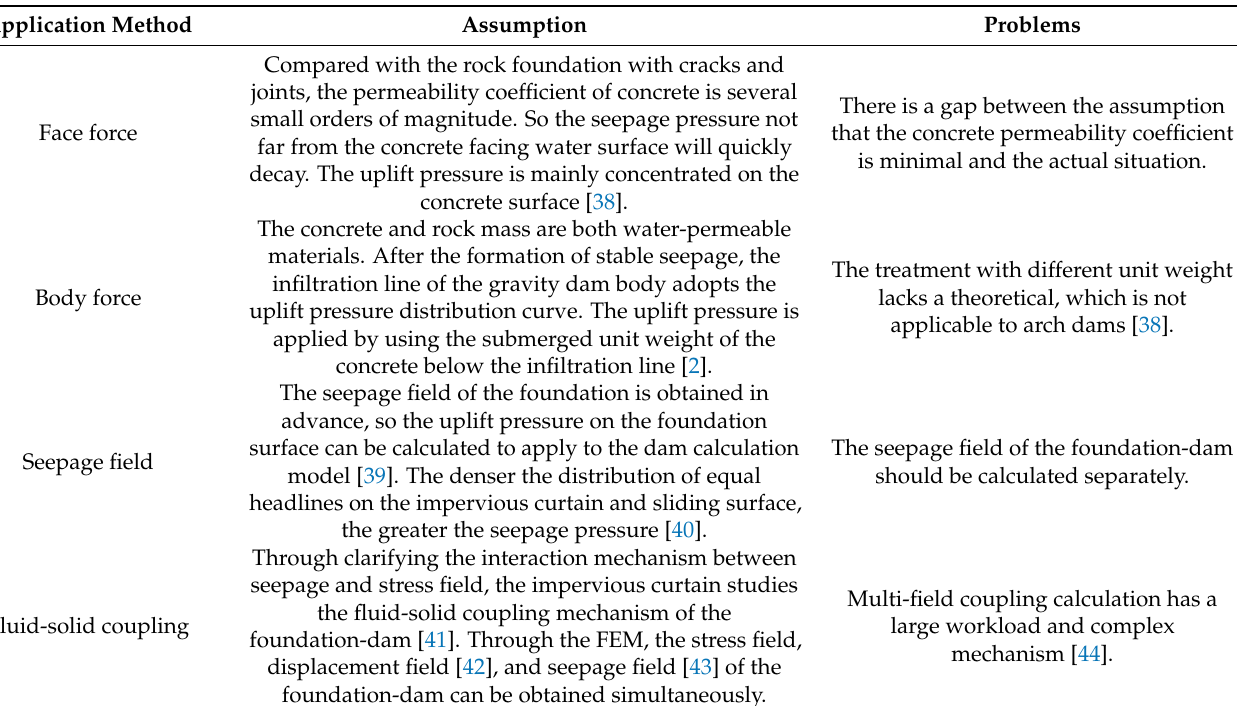
Table 1. Main methods of applying uplift pressure in FEM